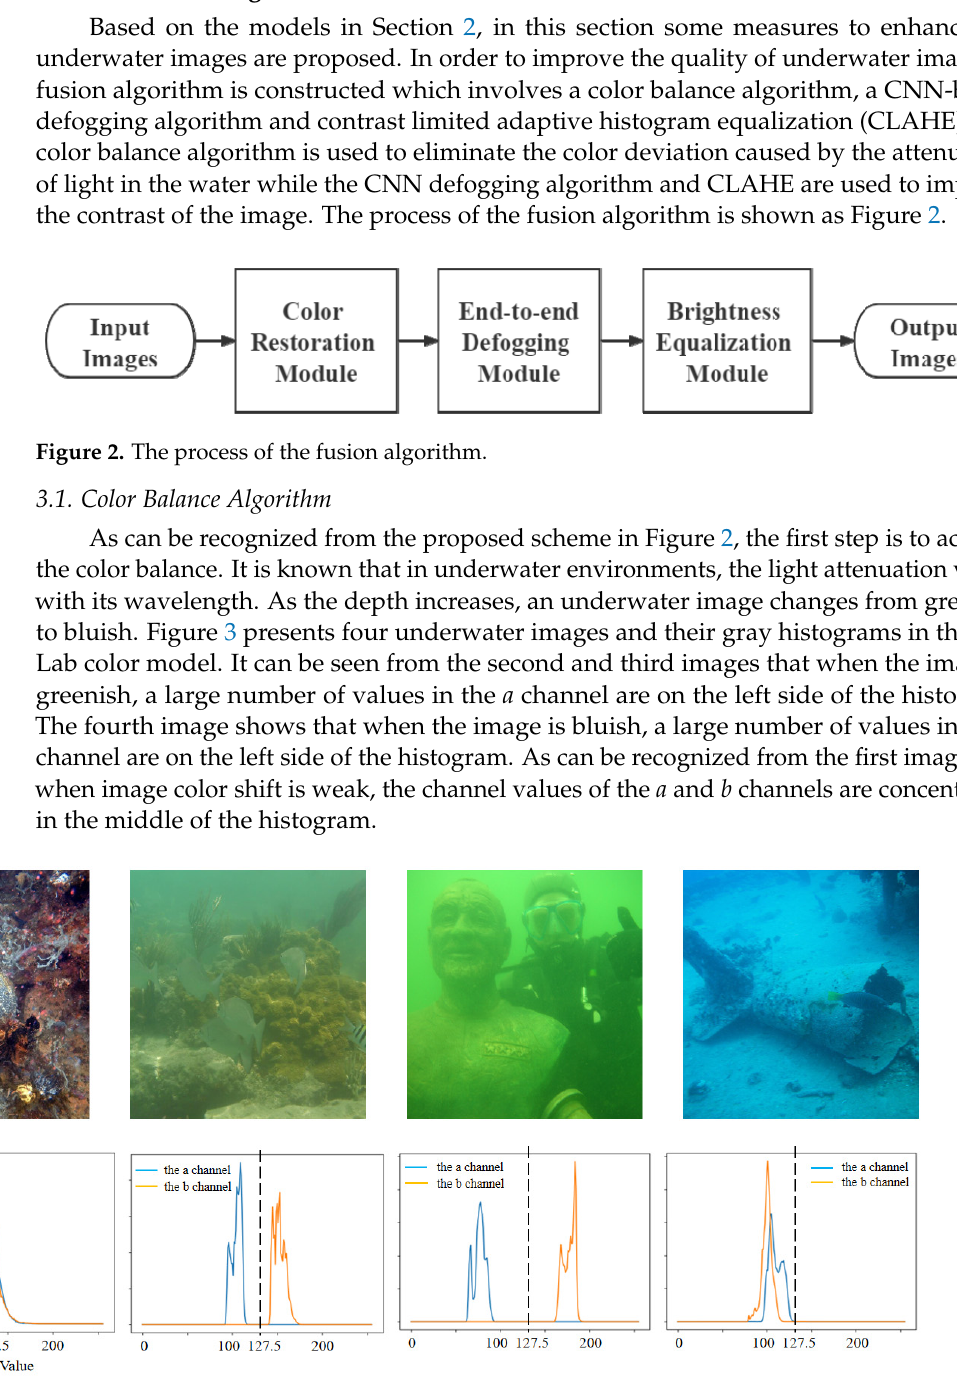
Figure 3. Underwater images and their gray histograms of color channels. The blue polyline rep- resents the a channel, and the orange polyline represents the b channel.